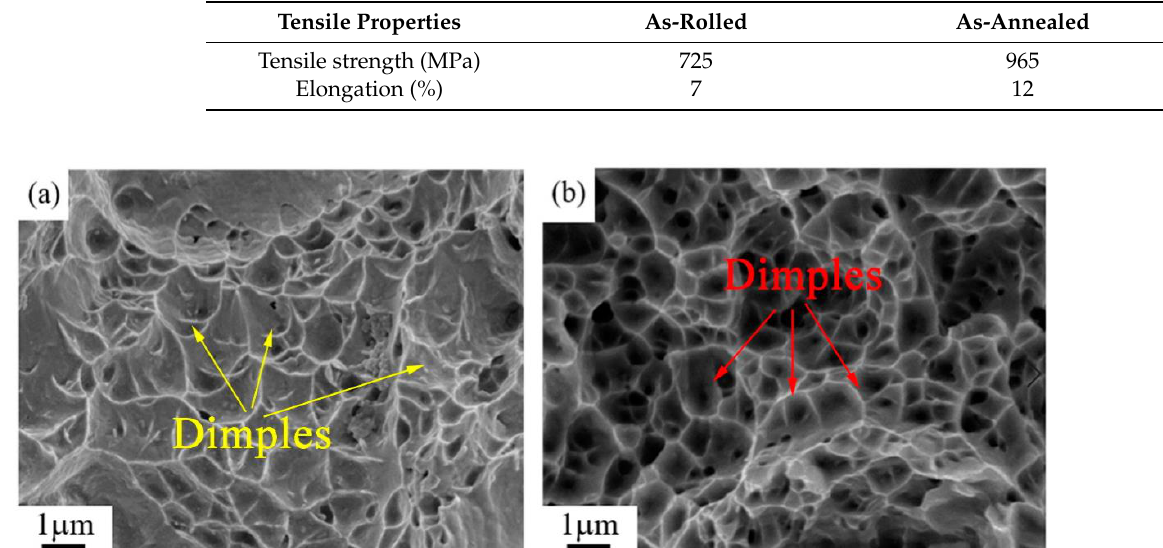
Figure 12. Fracture morphology of tensile samples: ( a ) solution-treated sample, ( b ) as-annealed sample.